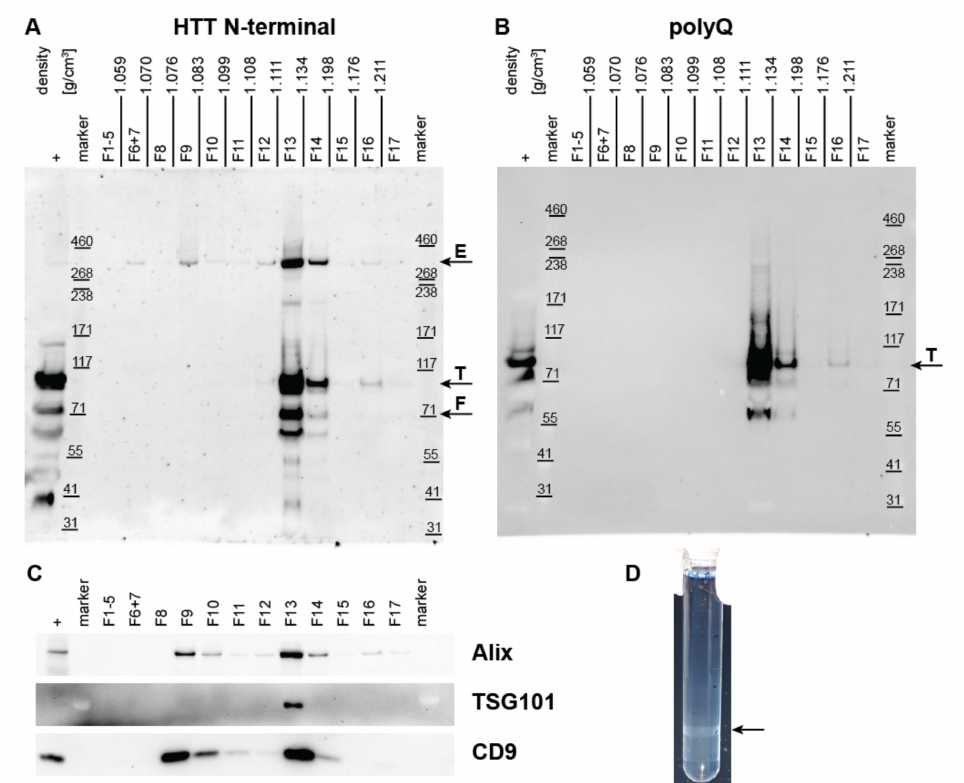
Figure 4. Huntingtin and exosome marker detection in fractions from density gradient ultracen- trifugation. The 100,000 × g pellet from the T131 transgenic pig plasma (sample labeled “+”) was overlaid by 40% to 5% OptiPrep and separated by gradient ultracentrifugation. Seventeen fractions (1 mL each) were collected from top of the tube. The collected fractions were subjected to SDS-PAGE and western blotting to detect total huntingtin ( A ), mutant huntingtin ( B ) and exosome markers Alix, TSG101 and CD9 ( C ). Huntingtin appeared in fraction 13 with density 1.111–1.134 g/cm 3 corresponding to exosomes. Fraction 13 was also positive to exosome markers. Arrows indicate ~360 kDa endogenous huntingtin (E), ~110 kDa huntingtin transgene (T) and ~70 kDa huntingtin fragment (F). The extracellular vesicles in fraction 13 macroscopically appeared as an opalescent band in the ultracentrifugation tube (arrow in panel ( D ). Representative results from 5 samples fractionated by gradient ultracentrifugation are shown (see Figures S8–S12 for full